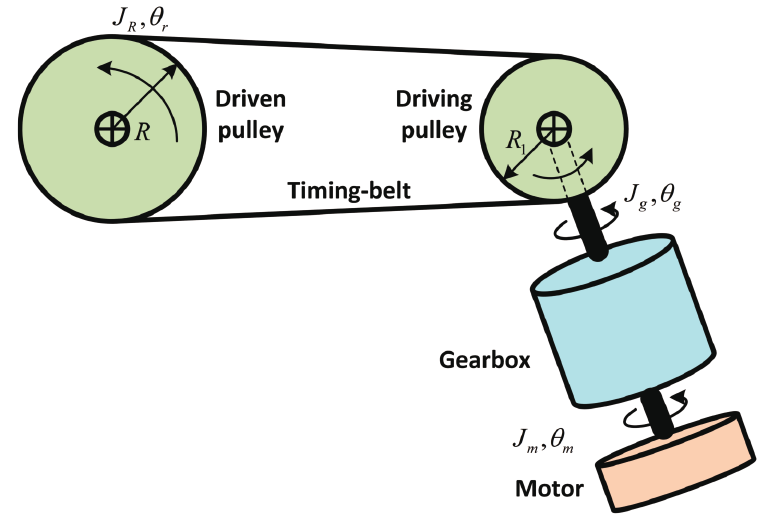
Figure 2. Schematic diagram of the timing-belt servo